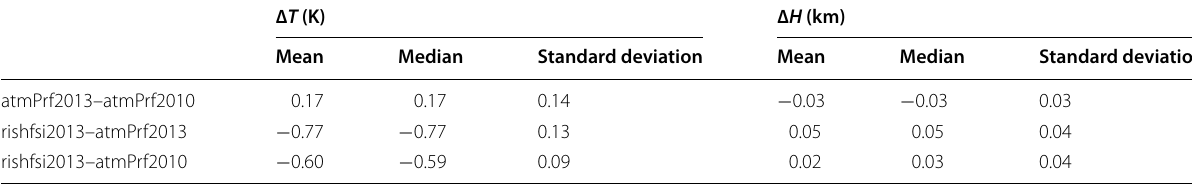
Table 2 Statistical differences of CPT among the three GPS-RO datasets ∆ T (K) ∆ H (km) Mean